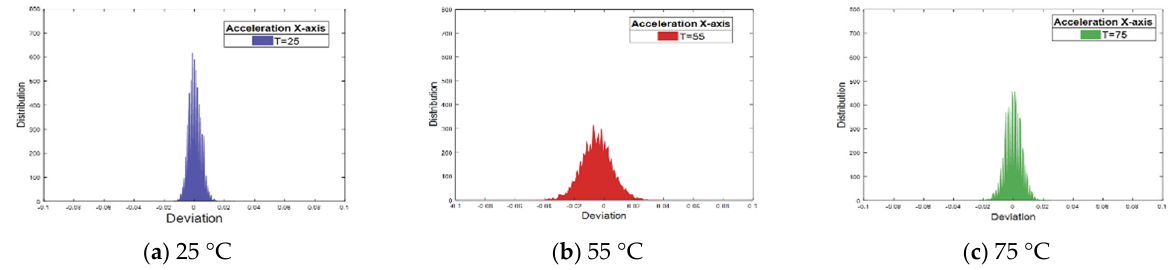
Figure 7. Noise distribution charts of the X ‐ axis of the accelerometer.